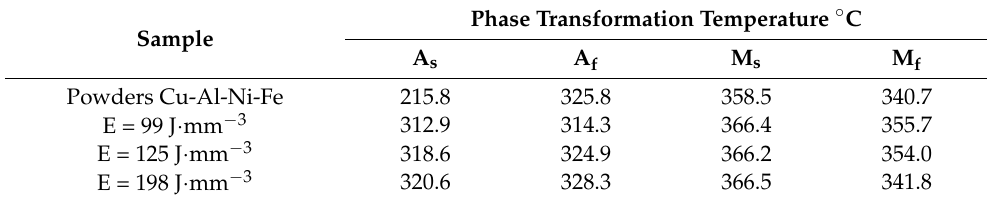
Table 1. Phase transformation temperatures obtained from DSC results.